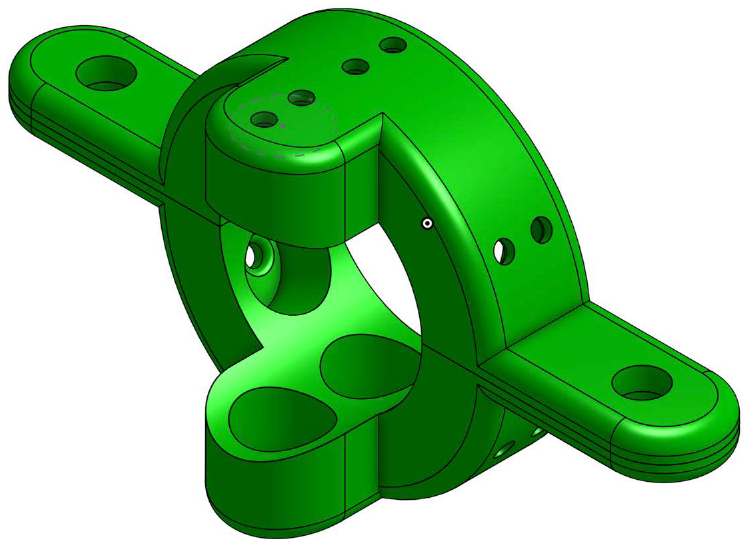
Figure 2. Clamp design: The clamp has a total of eight slots, six of which form a ring where transducers can be placed 60 degrees apart, and two additional slots which are 180 degrees apart for deploying additional transducers. This clamp was modified from the original design in